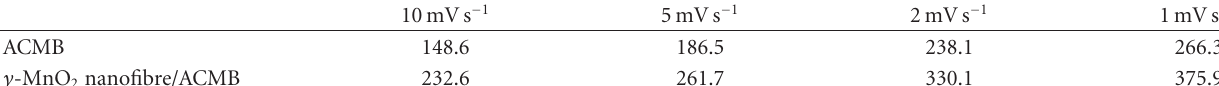
Table 1: Specific capacitance (Fg − 1 ) of ACMB and γ -MnO 2 nanofibre/ACMB at di ff erent scan rates ·